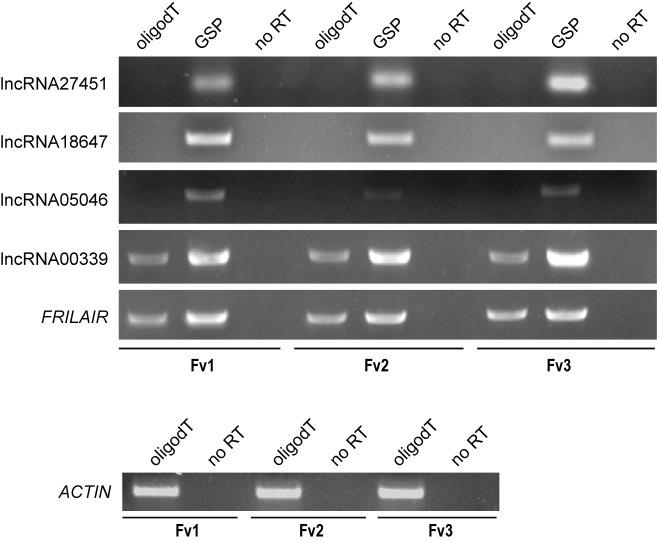
Detection of lncRNAs in strawberry fruits at three developmental stages.RT-PCR analyses were carried out on selected lncRNAs (lncRNA27451, lncRNA18647, lncRNA5046, lncRNA00339 and FRILAIR) in strawberry fruits from three different growth stages including Fv1, Fv2 and Fv3. Either oligo-dT or gene-specific primers (GSP) were used in the cDNA synthesis and no Reverse Transcriptase was used as negative control (no RT). Control RT-PCR using ACTIN primers is present on the bottom panel.